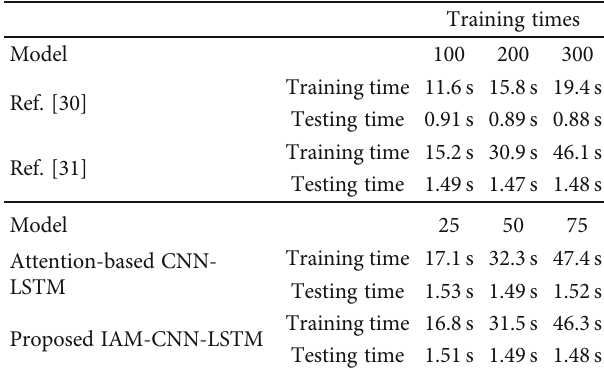
Table 6: Comparison of the prediction time of the proposed and existing algorithms.